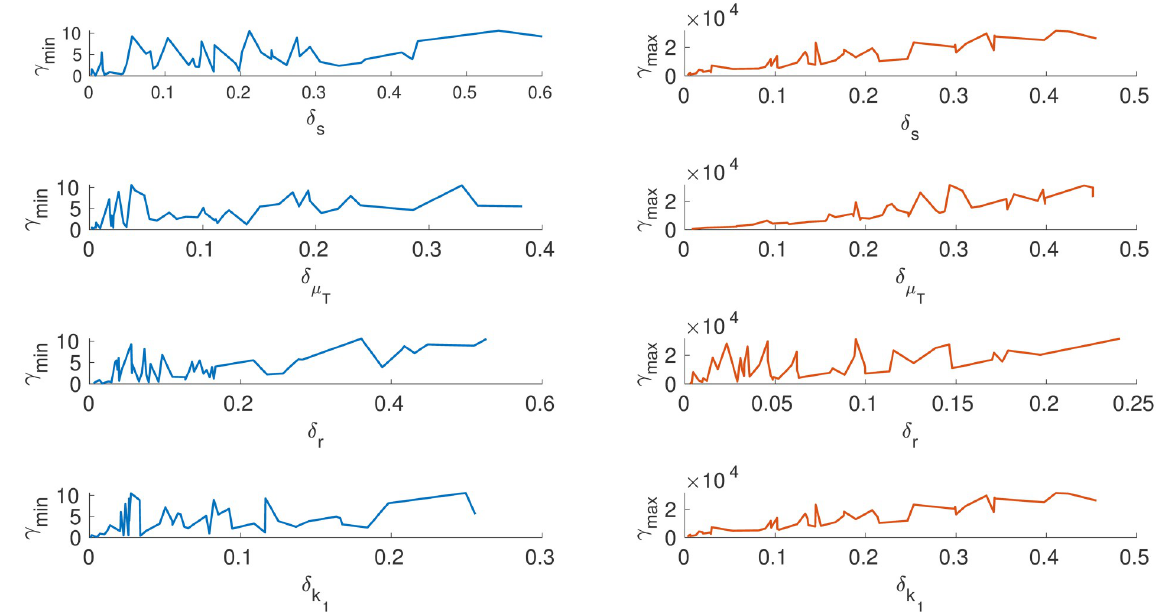
Fig 12. x -axis depicts the relative distance of the particular parameter θ square deviation, and on the right maximum sum-square deviation from y � ( t ). Parameter r is more sensitive when compared to other parameters in the direction of maximum deviation.